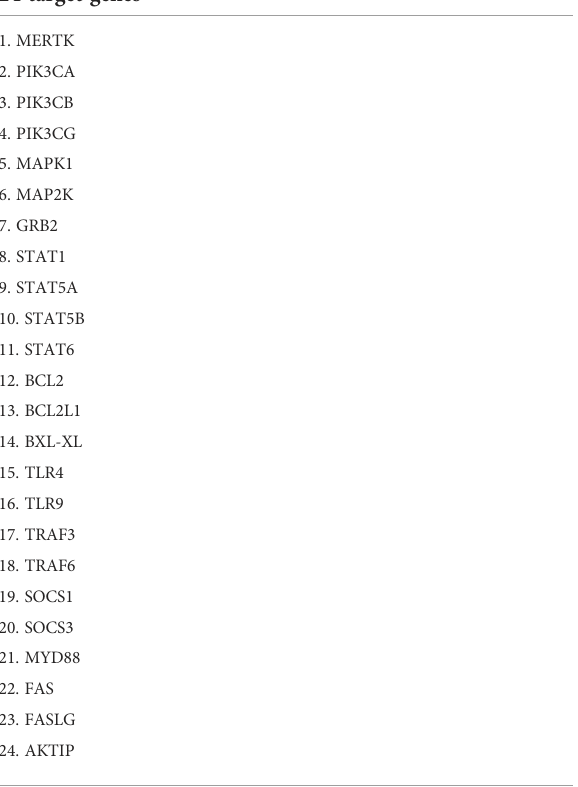
TABLE 2 List of 24 target genes of RT2 Pro fi ler PCR Array